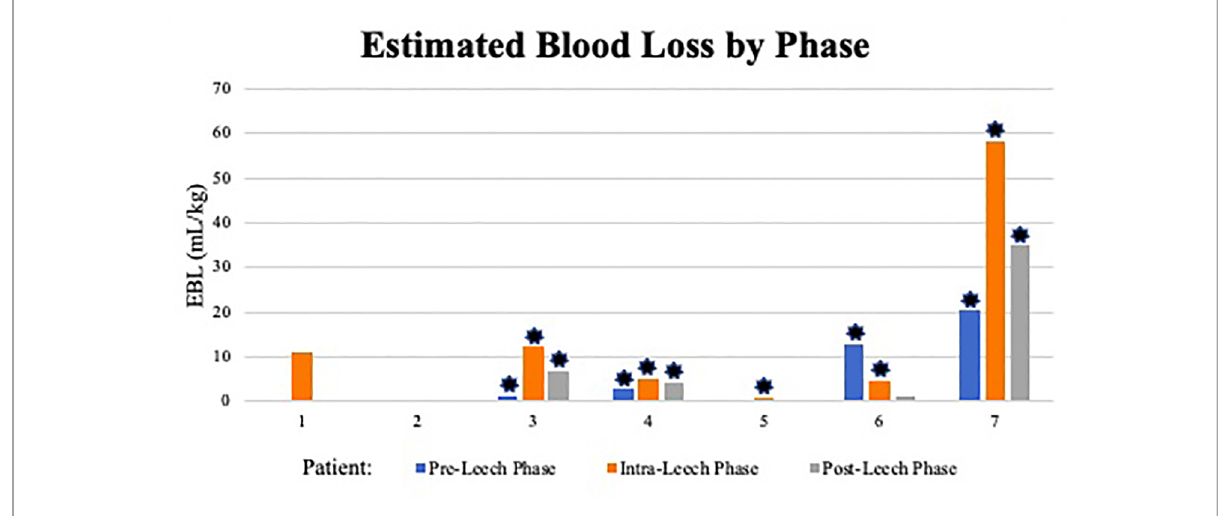
FIGURE 2 Estimated blood loss by phase. ml, milliliter; kg, kilogram; *: indicates ECMO use within